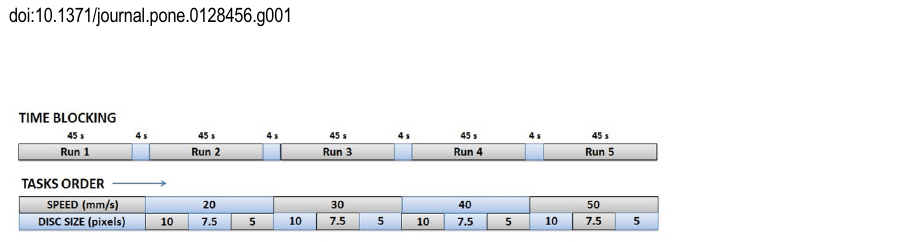
Fig 1. Experimental environment showing the subject performing the tracking movements in front of a screen. The subject should follow the red circle by controlling a black cursor with the planar manipulandum.